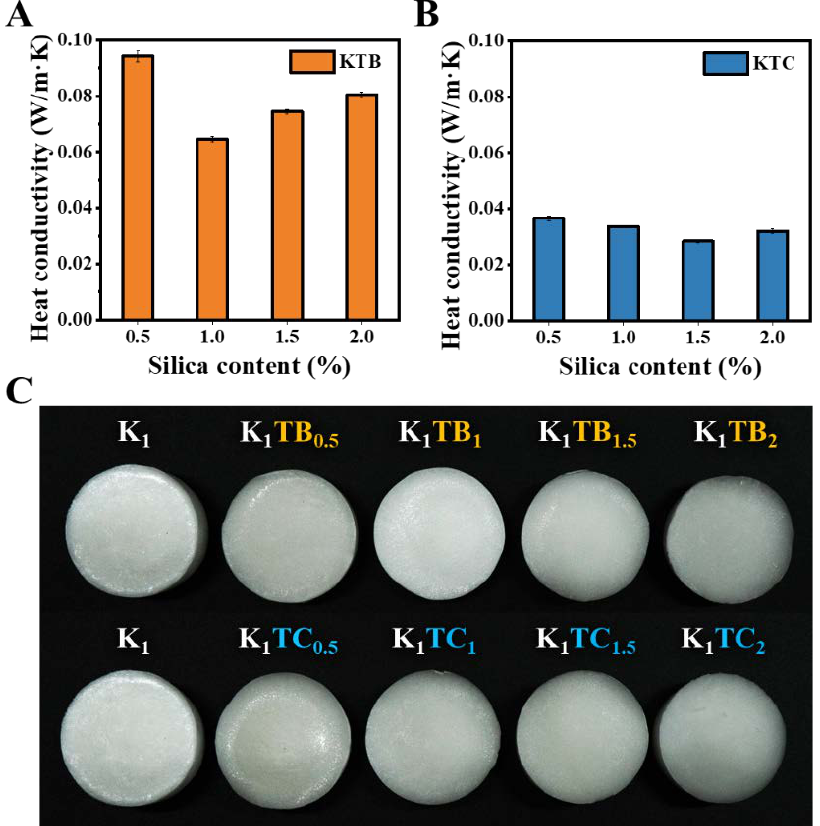
Figure 6. Thermal conductivities of KTB aerogels ( A ) and KTC aerogels ( B ), and macrographs of K 1 , KTB, and KTC aerogels with a diameter of 4 cm ( C ).